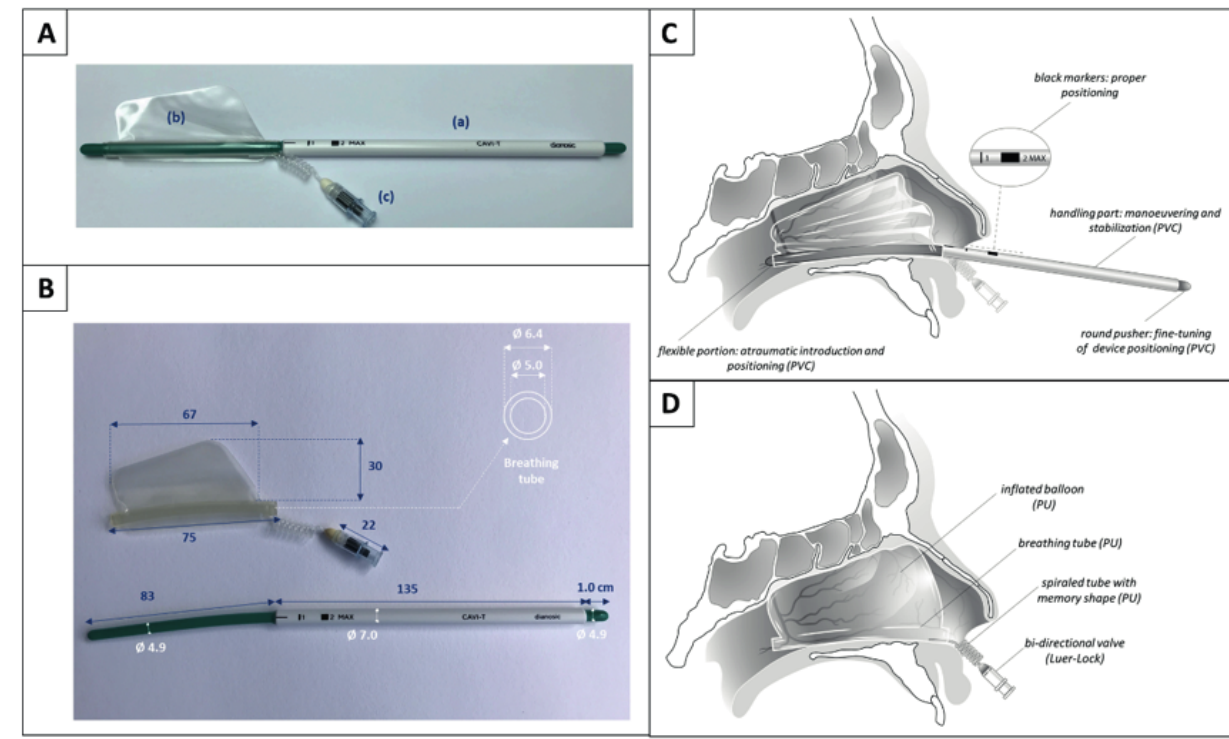
Figure 1. A. Components of the CAVI-T™ device - (a) deployment guide, (b) balloon, (c) bi-directional valve ; B. Details of the dimensions of the differ- ent components ; C. Sagittal section showing the insertion of the non-inflated balloon with the deployment guide ; D. Sagittal section showing the positioning of the inflated balloon in the nasal